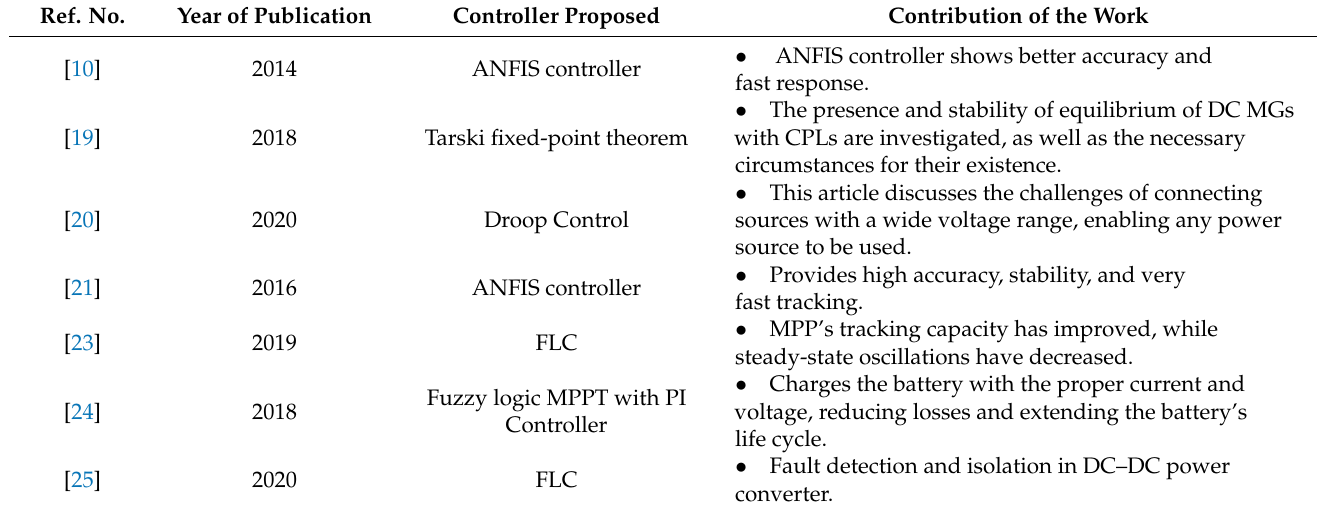
Table 1. Comparative analysis of the literature